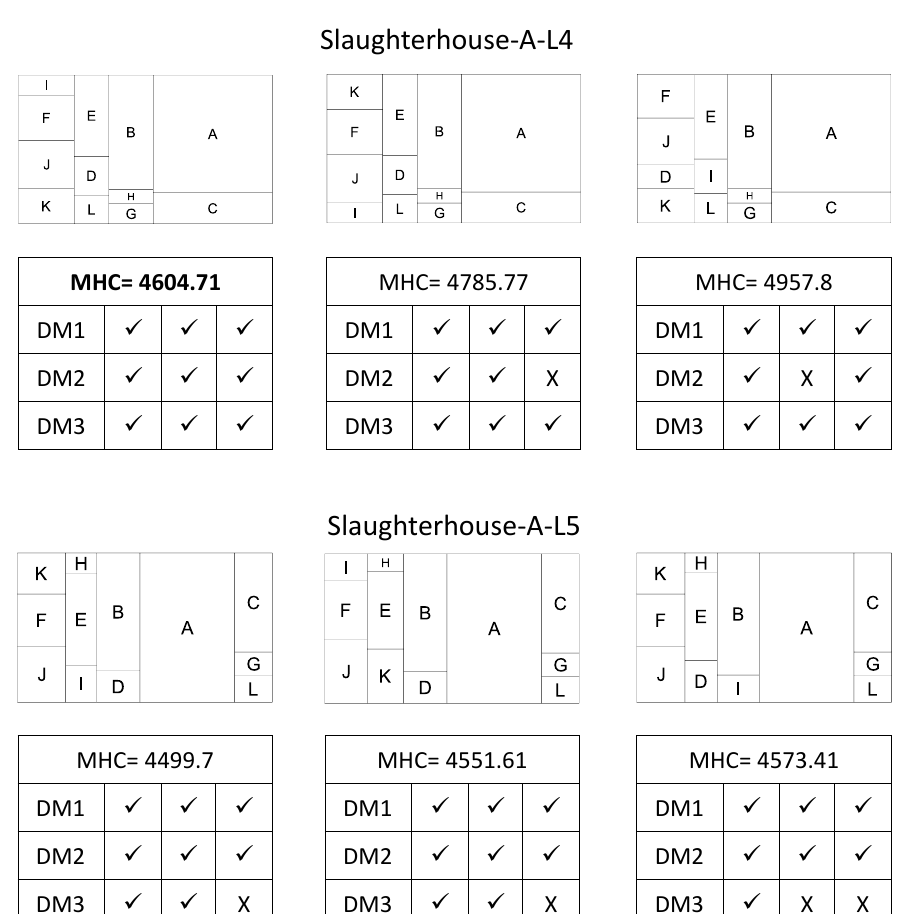
Figure 8. Best solutions found in Alternative launch 4 to 5 of Slaughterhouse